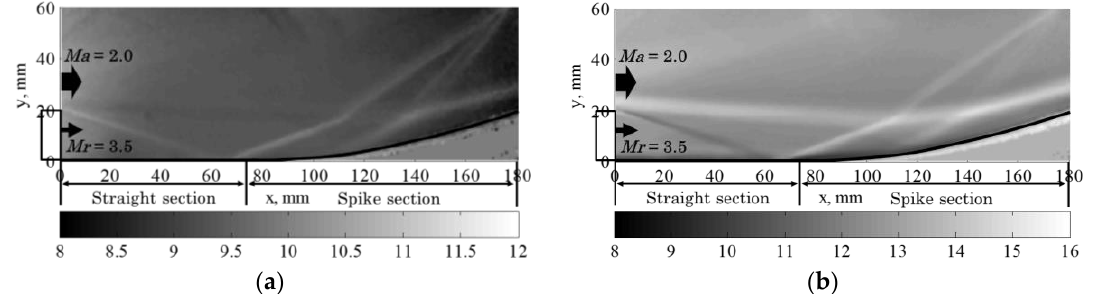
Figure 5. Raw single-shot images: ( a ) Reference (background) image (with only external flow); and ( b ) experimental image (with both external and cell nozzle flows). The figure shows the case of an overexpansion condition, with the flow direction from left to right. Figure 6. Displacement field obtained by BOS ( a ) in the x -direction; and ( b ) in the y -direction. The flow direction is from left to right, and the color bar indicates pixel displacement.